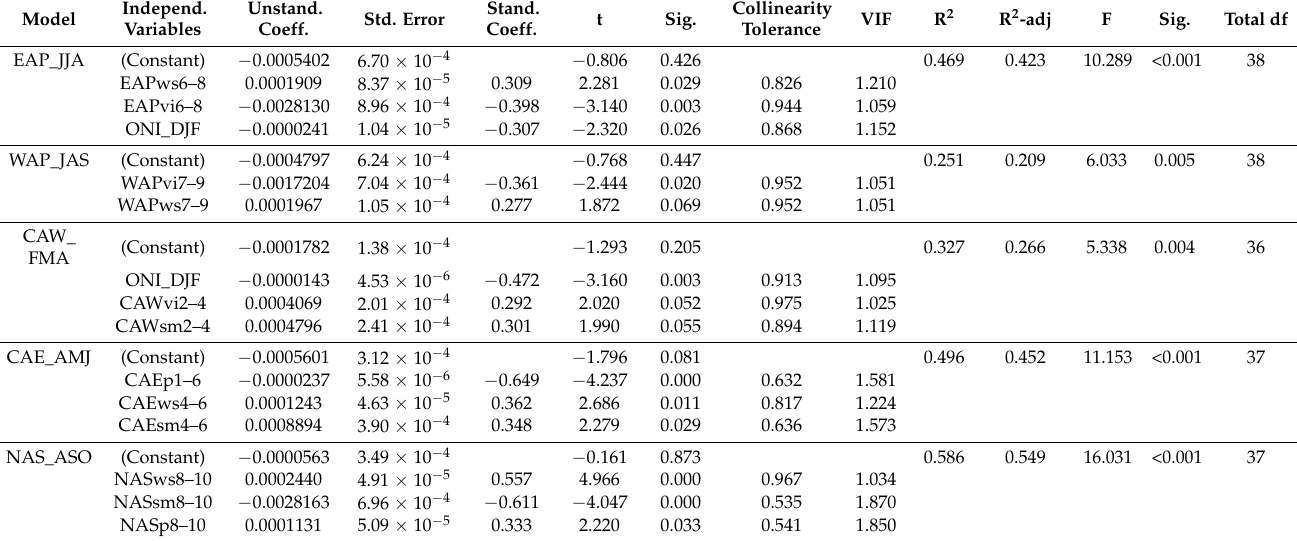
Table 4. Multiple linear regression with the 3-month dust column mass density when its correlation with ONI_DJF was highest as the dependent variable and major factors of dust activity and ONI_DJF as the independent variables. For the independent variables, the names contain the acronyms of subregions, factors (p = precipitation, ws = mean maximum daily wind speed, vi = NDVI, and sm = soil moisture (root zone wetness)), and the ranges of the specific 3-month periods or cumulative precipitation from January (e.g., 6–8 =